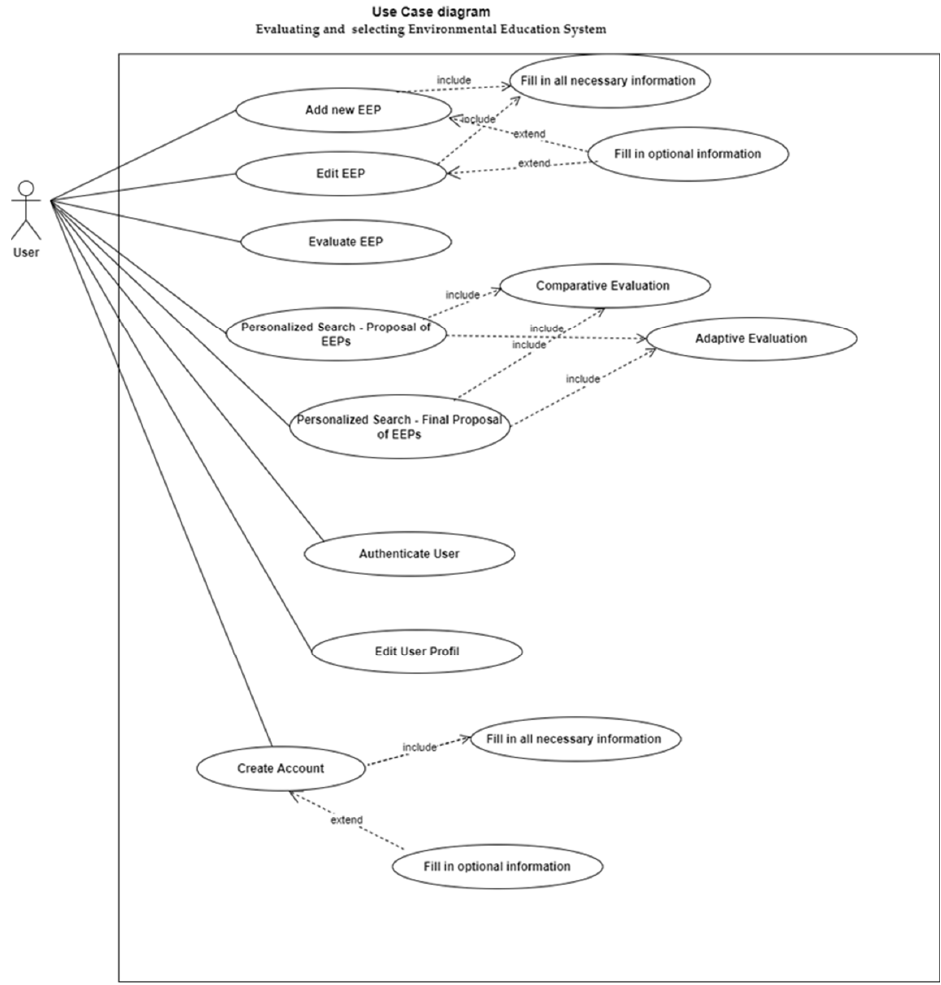
Figure 2 . Use Case Diagram . Figure 2. Use Case Diagram.